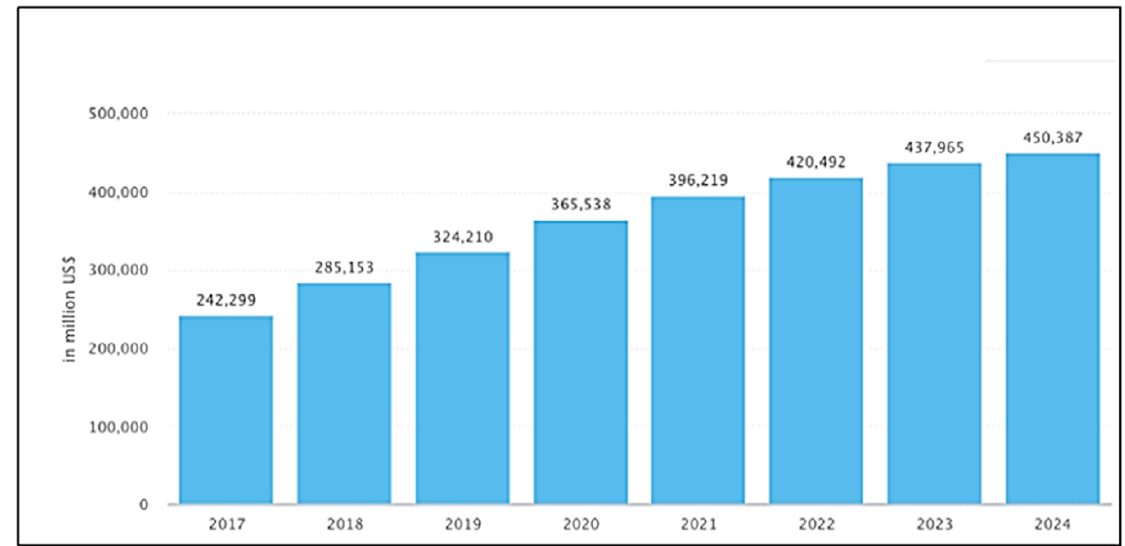
Figure 1. Consumer electronics growth in USD up to 2019 and the projected growth after 2019 [33]. Original source ([33]) followed by the IEEE copyright line © 2020